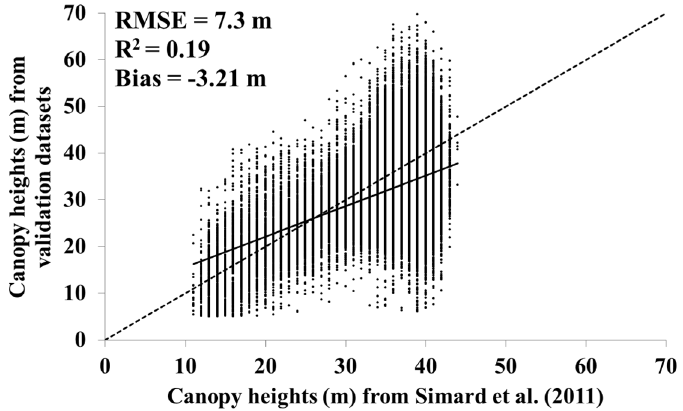
Figure 9. Comparison between the canopy heights of our verification datasets (LD_val and HD) and the canopy height estimates from the study of [10].